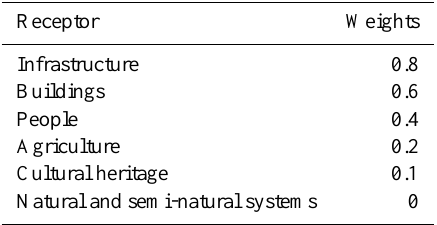
Table 16. Weight assigned to different receptors by local experts and relevant stakeholders.